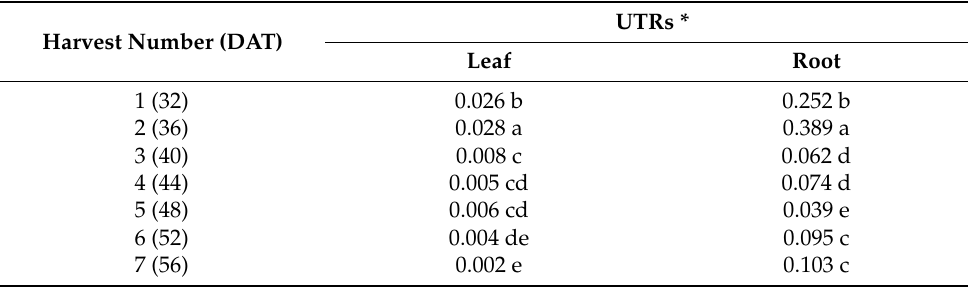
Table 5. Uptake ratios (UTRs) of diazinon in